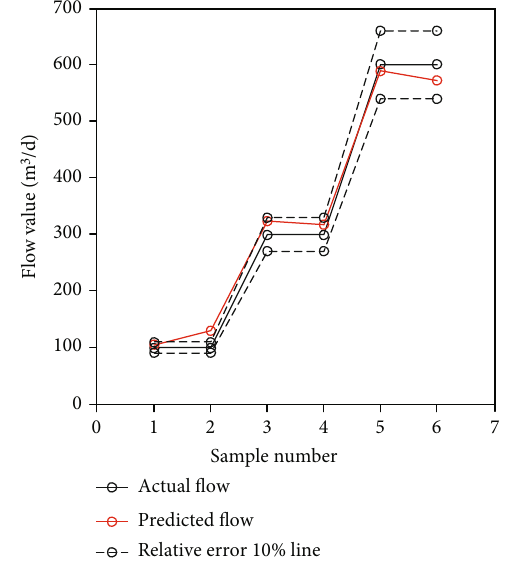
Figure 20: Histogram of the predicted value error of model